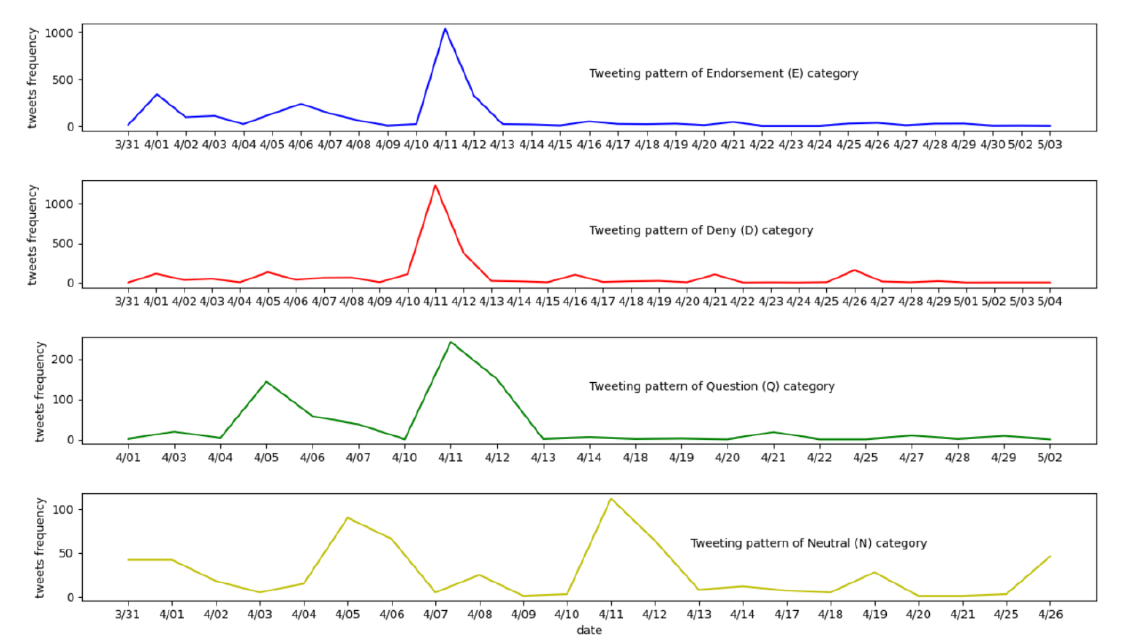
Figure 2. Tweeting pattern of endorse (E)-deny (D)-question (Q)-neutral (N) user reaction polarities.